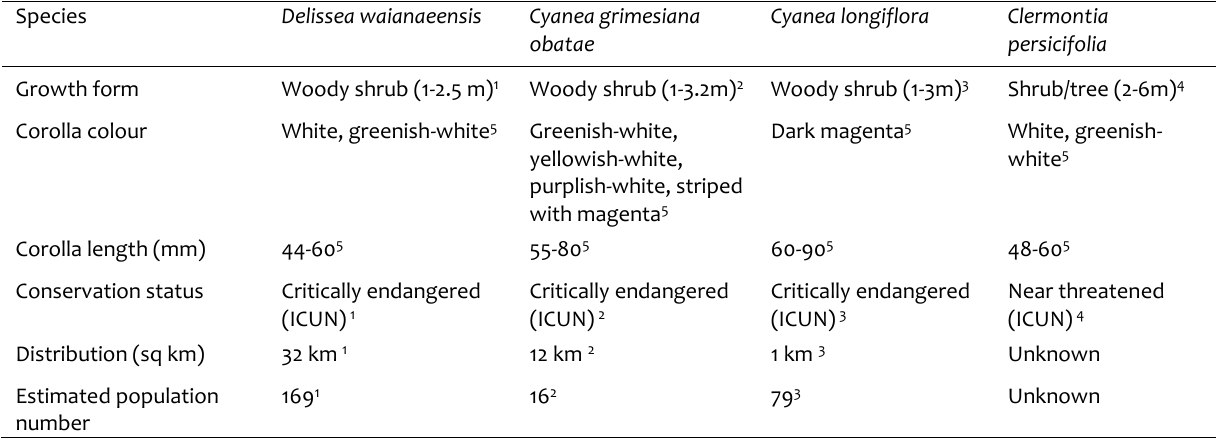
Description and conservation status of lobelioid species examined.